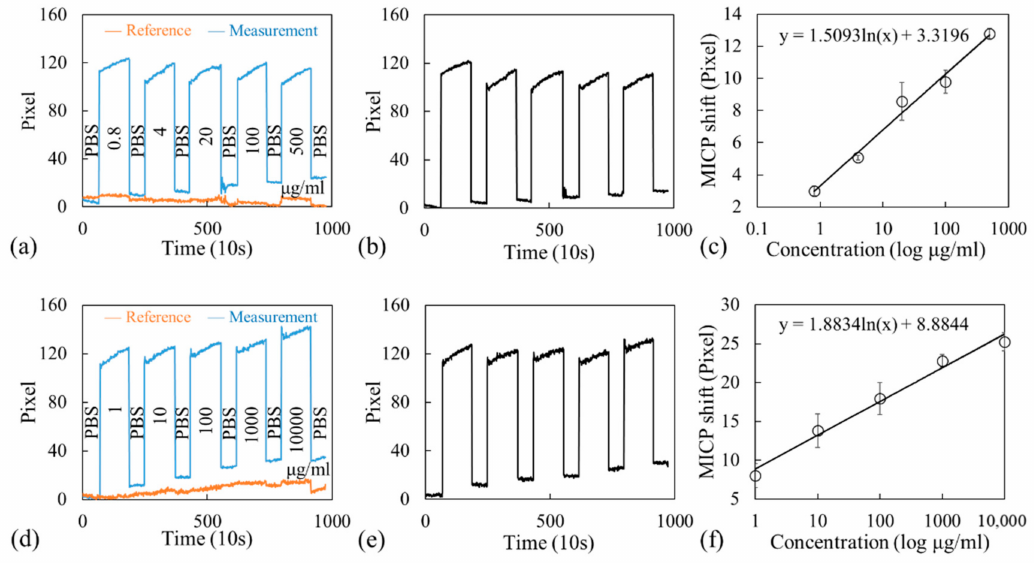
Figure 6. ( a – c ) Albumin and ( d – f ) creatinine detection results. ( a , d ) show the shift in MICP with respect to time for both the reference and measurement channels. ( b , e ) show the net shift in MICP with respect to time. ( c , f ) show the response